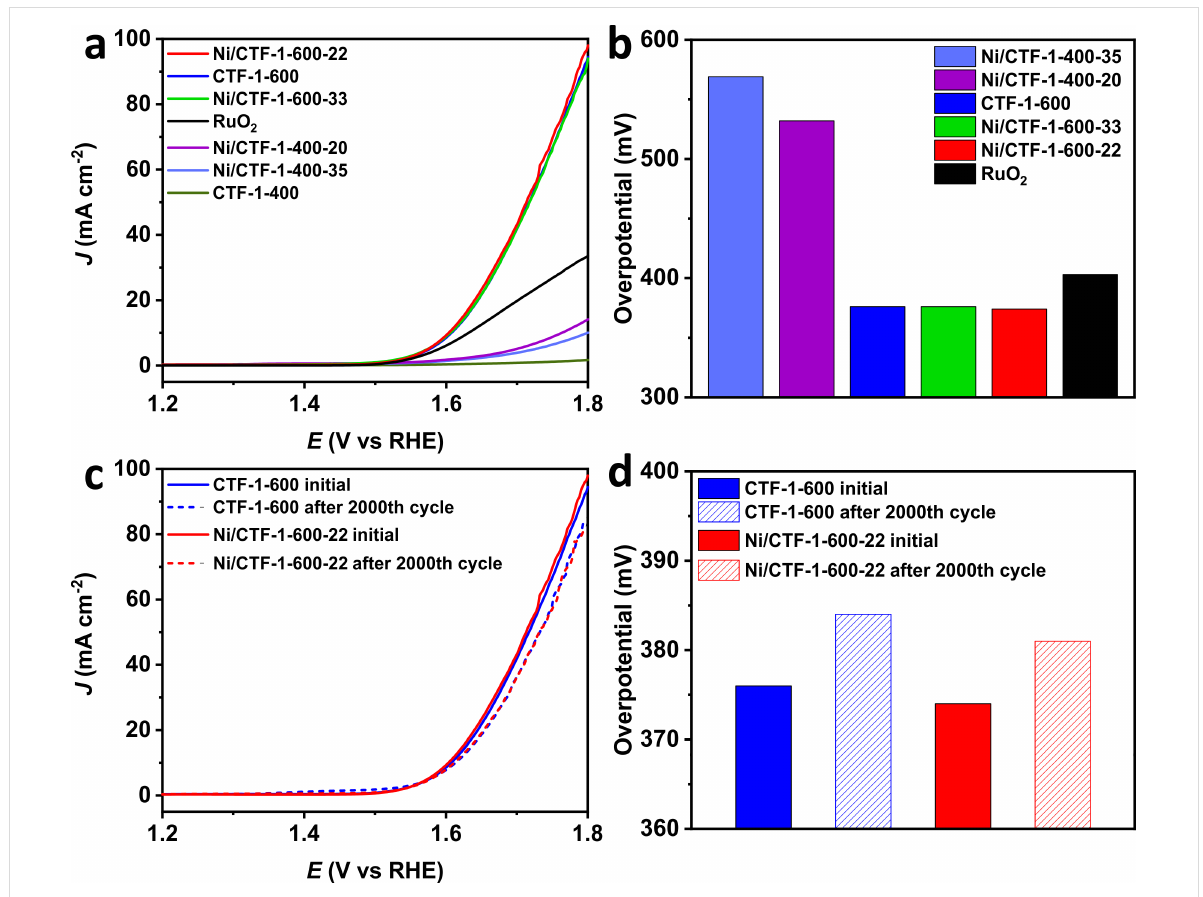
Figure 6: (a) OER polarization curves of various materials, (b) overpotential values calculated from (a); (c) OER polarization curves for CTF-1-600 and Ni/CTF-1-600-22 after 2000 cycles, (d) overpotential values calculated from (c).